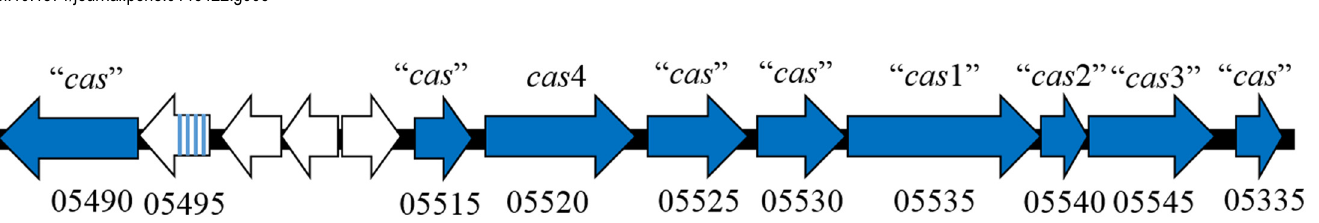
Fig 6. An unrooted phylogenetic tree of “ Candidatus Liberibacter asiaticus ” strains based on spacer 2 sequences of CRISPR (clustered regularly interspaced short palindromic repeats) array. HN, GX, YN, ZJ, JX, GD and GZ represent the CLas strains from Hainan, Guangxi, Yunnan, Zhejiang, Jiangxi, Guangdong and Guizhou provinces, respectively. Published prophages are identified in red. Prophage gxpsy-2, identified by * , is a Type 2 prophage based on sequence mapping results. Numbers at each branch are boostrap values supported in 1,000 replication by neighbour-joining method.